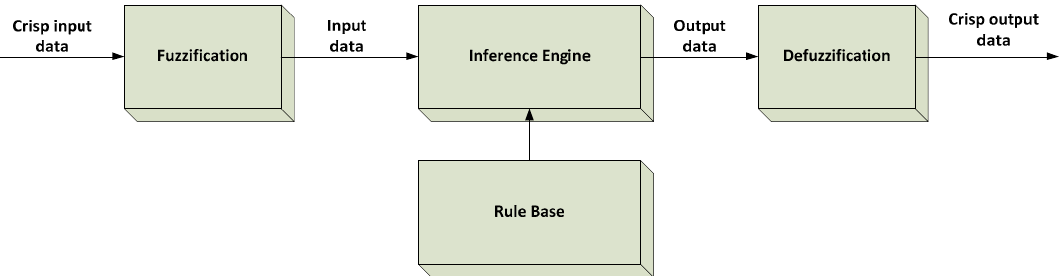
Figure 1. Block of fuzzy logic control system.